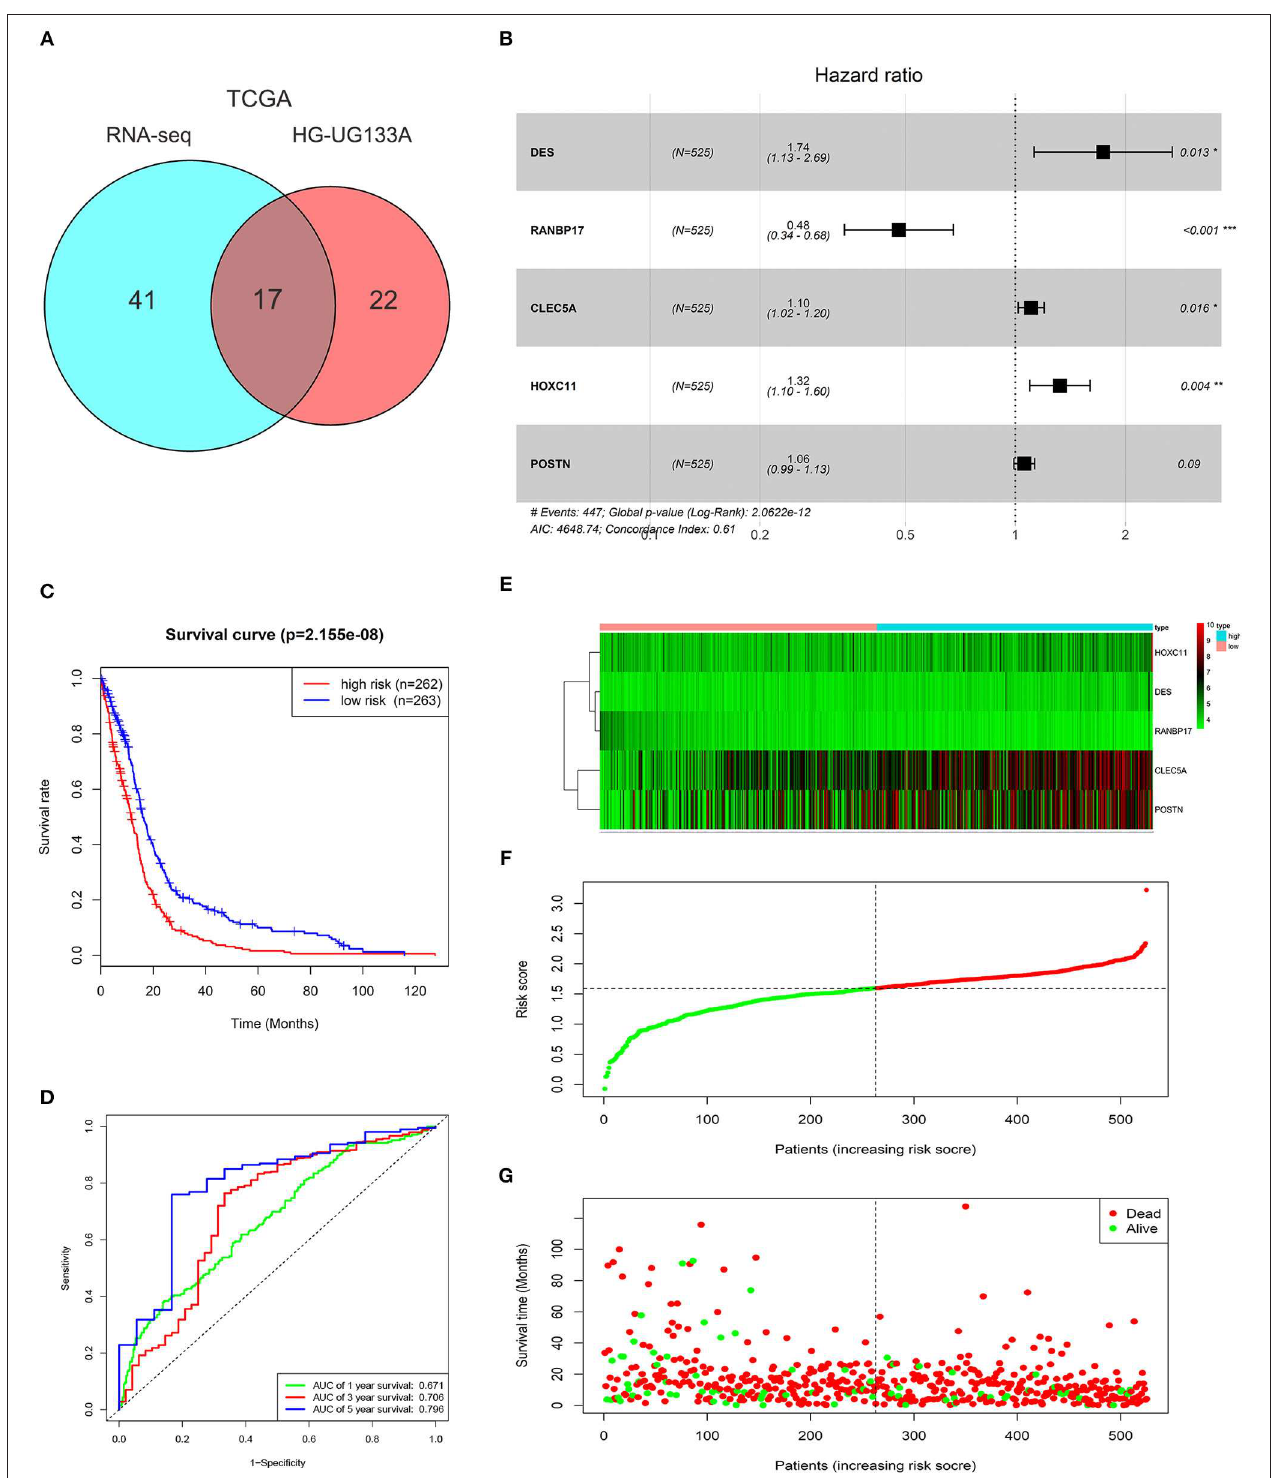
FIGURE 2 | Characteristics of the risk signature with five genes. (A) Venn diagram showed 17 common genes correlated with overall survival ( P < 0.05) between TCGA GBMLGG (RNA-seq) and HG-UG133A platforms. (B) Multivariable Cox regression analysis was performed and five genes (DES, RANBP17, CLEC5A, HOXC11, POSTN) were selected to construct the risk signature. (C) Difference of overall survival between low-risk and high-risk groups ( P < 0.0001). (D) ROC analysis of 1, 3, 5-year survival according to the five-gene risk signature. (E) The expression levels of the five genes (DES, RANBP17, CLEC5A, HOXC11, POSTN) in the signature. (F) The distribution of the five-gene signature risk score for each patient. (G) The survival time of each patient with GBM and their survival status.